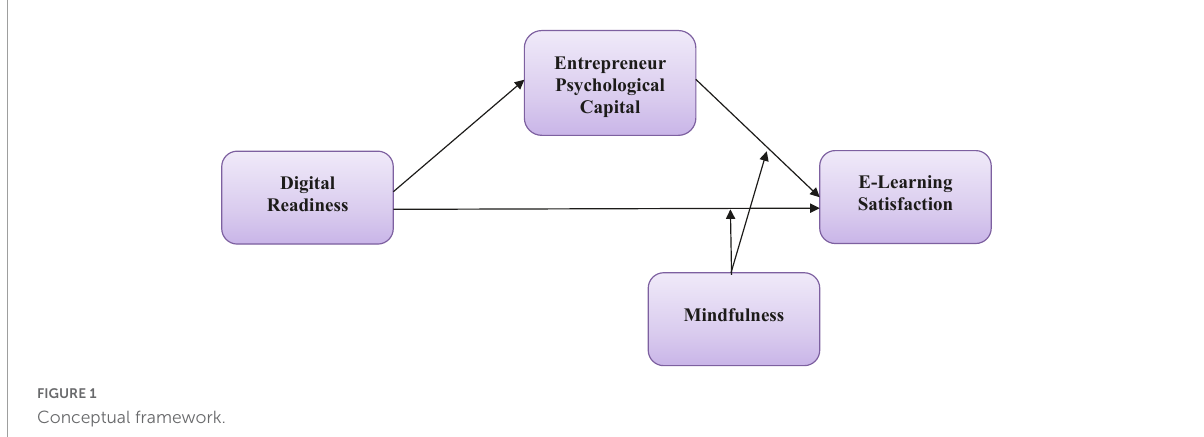
FIGURE1 Conceptual